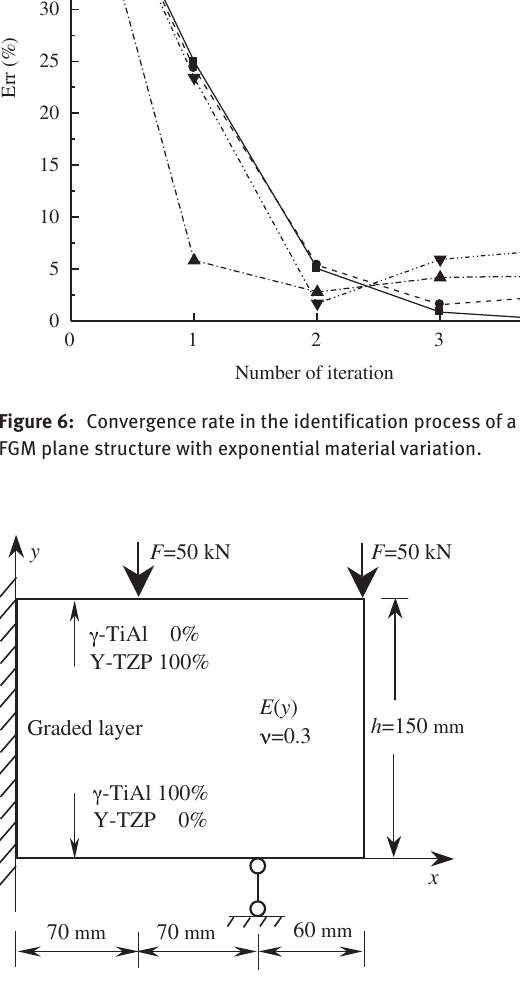
Figure 7: Rectangular FGM plane structure.